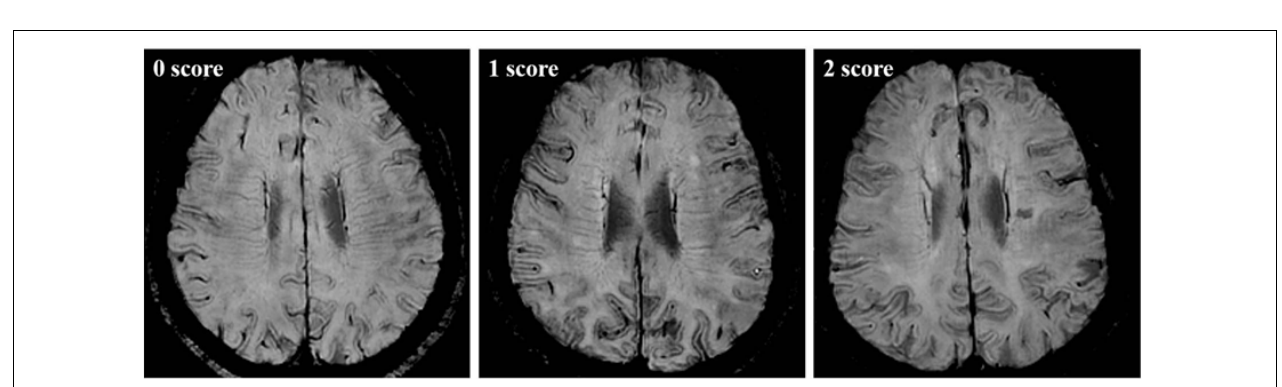
FIGURE 2 | Example images of venous disruption on SWI